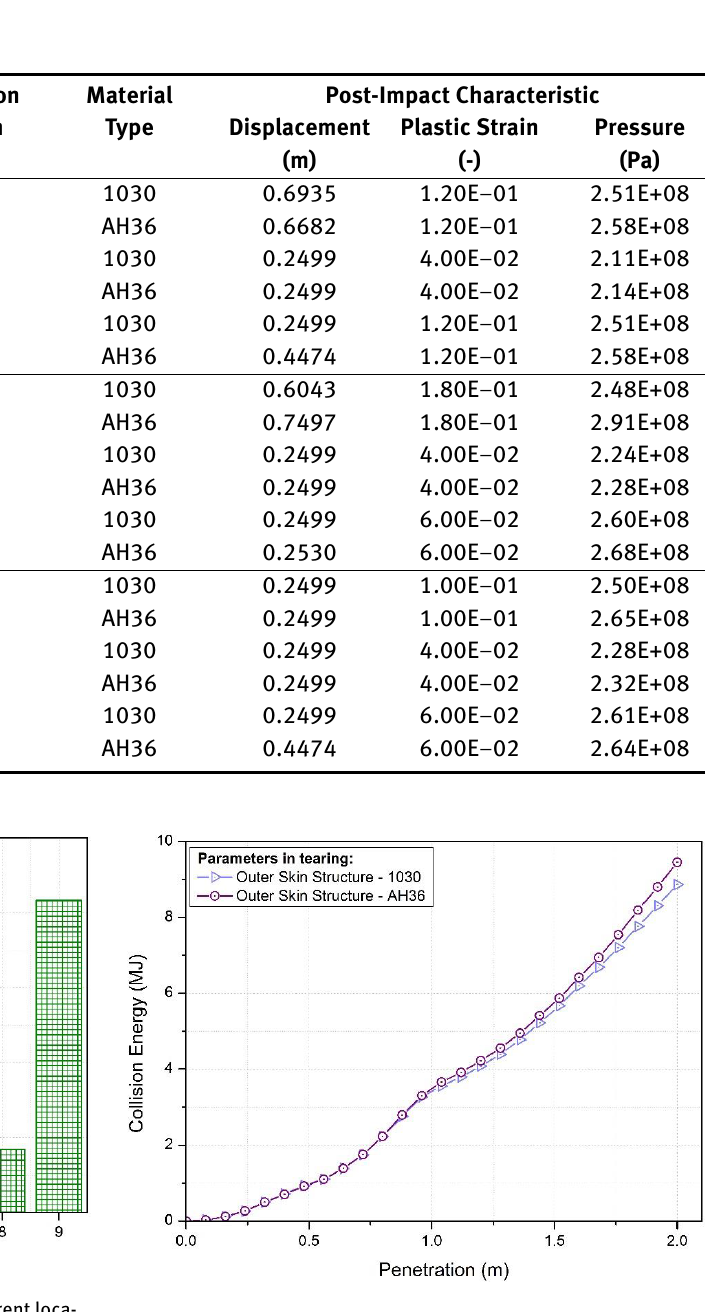
Figure 17: Energy pattern during hole formed in the end collision